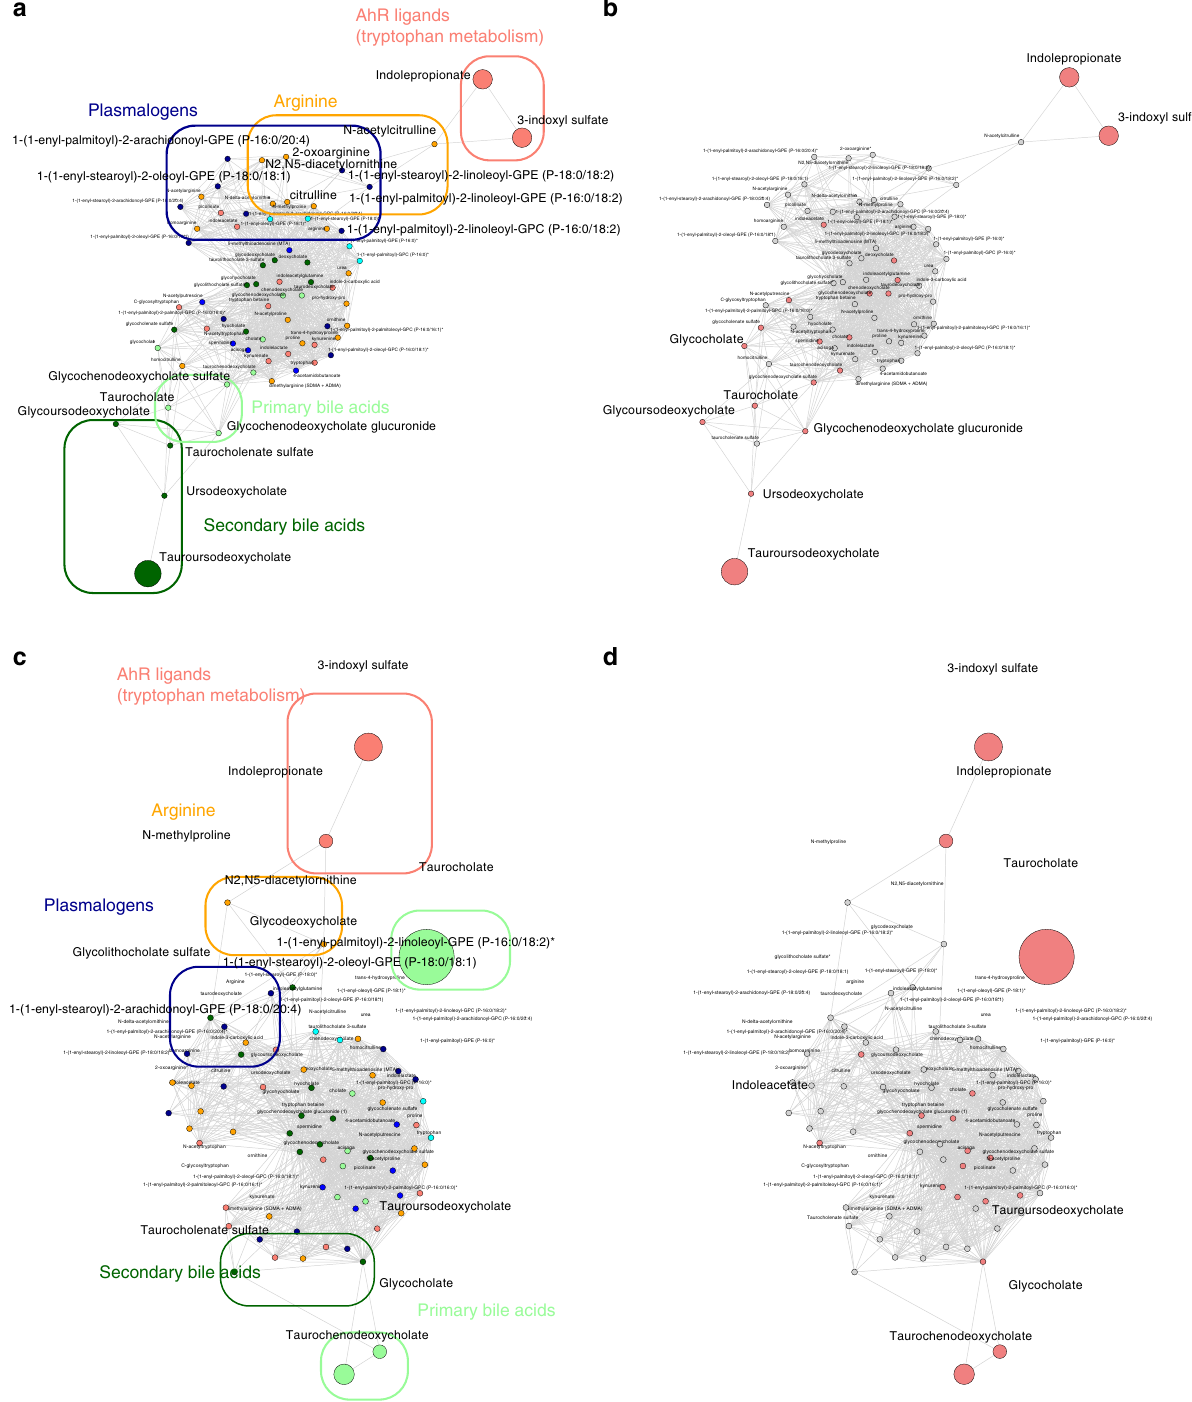
Fig. 5 Metabolomics variation at aGvHD onset is not affected by age, gender, nor BMI. Recipients with or without GvHD were compared after adjustment for age, gender, and body mass index (BMI) and re-analyzed to avoid any metabolite variation due to these parameters. The list of 57 metabolites signi fi cantly changing with acute GvHD onset in both cohorts is available in Supplementary Data 13. The main pathways involved at GvHD onset were used to build a network of compositional data where nodes represent metabolites and are linked if the ratio between corresponding metabolites was not signi fi cantly different between groups of patients. The same network was fi rst colored according to the considered sub-pathway for cohorts 1 and 2 ( a and c , respectively) and then according to microbial-derived metabolites (red nodes) ( b and d ,